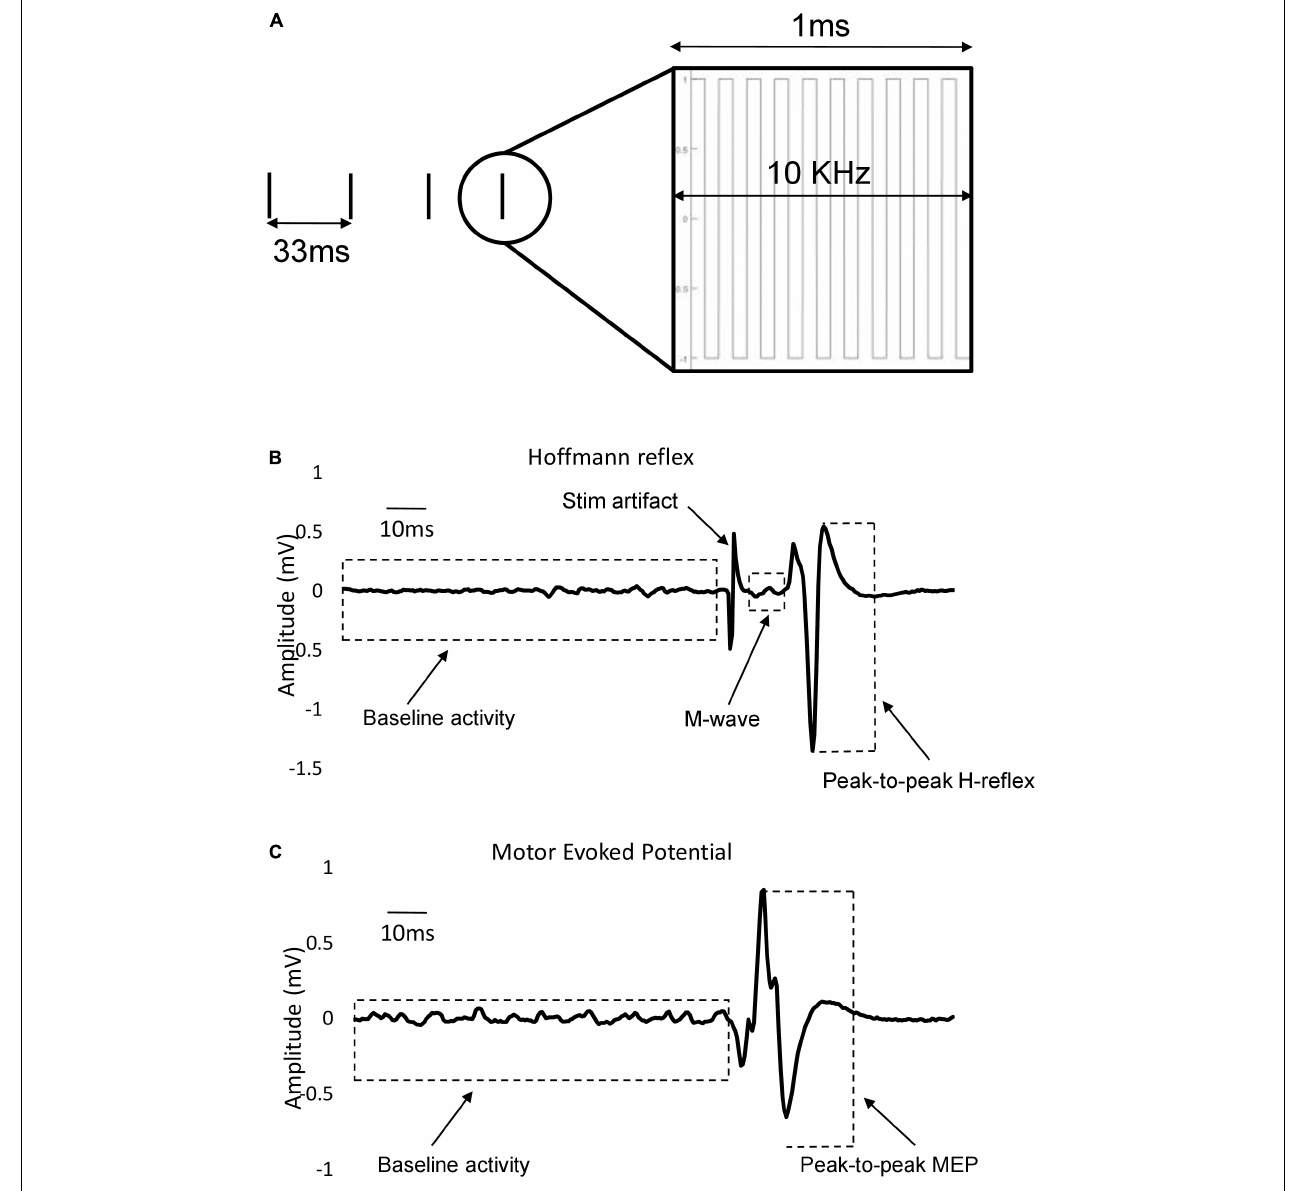
FIGURE 3 | Stimulation parameters and waveforms. (A) Stimulation pattern: Envelops of 1 ms-long burst of 10 kHz square-wave biphasic pulses carried at the rate of 30 Hz. (B) Representative example of individual evoked FCR H-reflex trace that also encompasses M-wave, stimulation artifact and baseline activity. Different components are measured in a 400-ms window (starting at 100 ms pre-stimulus to 300 ms post-stimulus). Peak-to-peak H-reflex amplitude used in data analysis is shown with dashed lines. (C) Single example of recorded FCR MEP trace with pre-stimulus baseline activity. Peak-to-peak MEP amplitude used in data analysis is shown with dashed